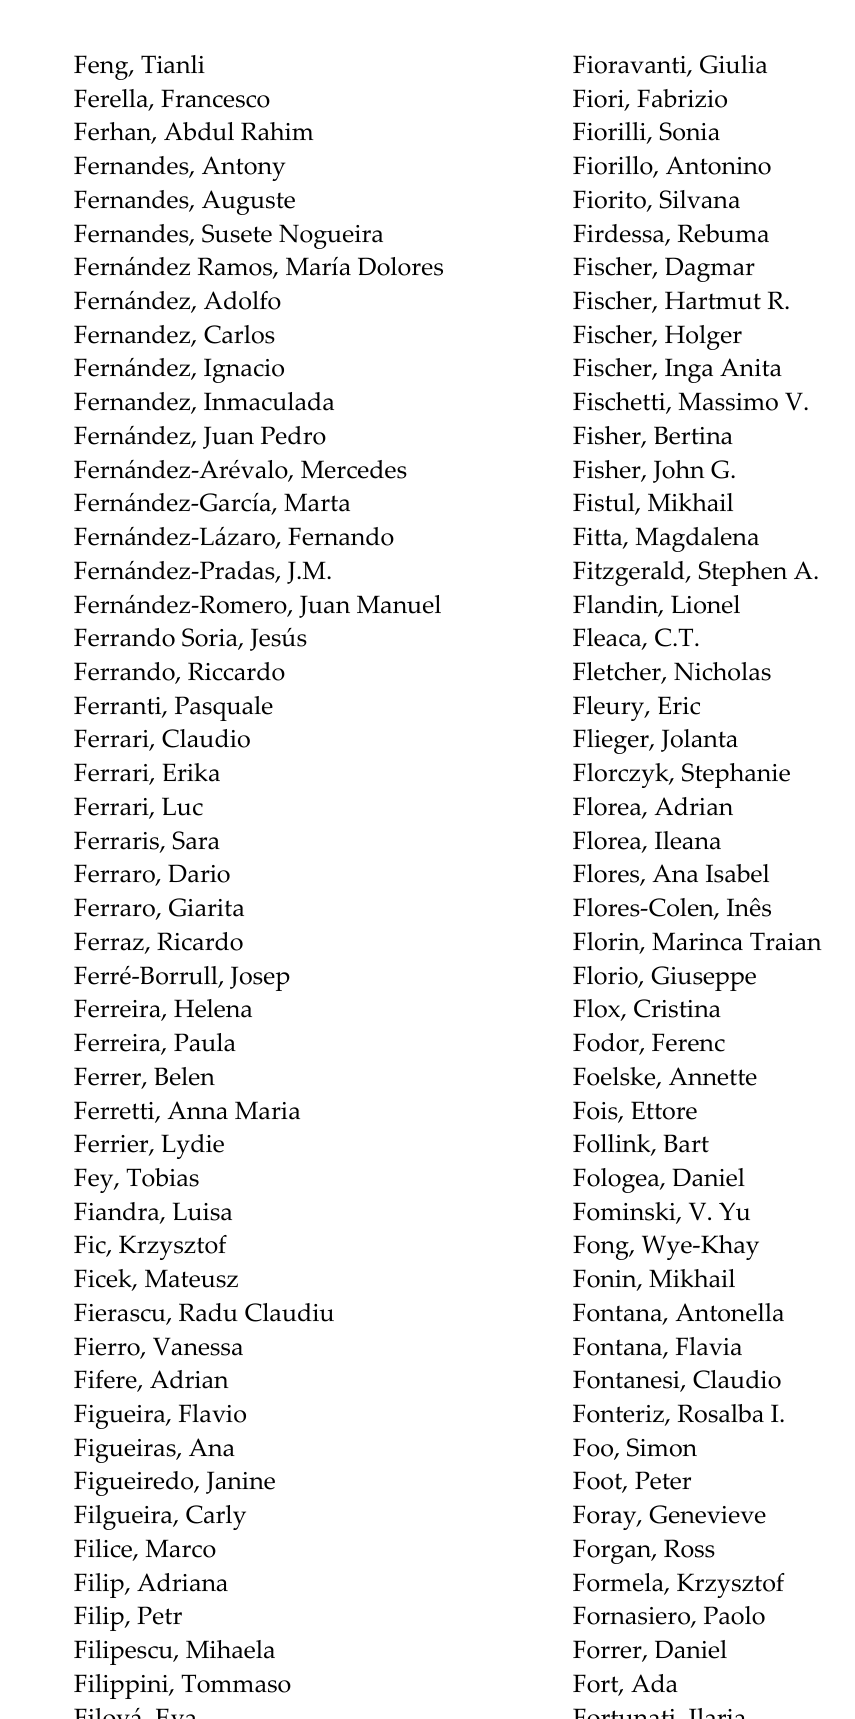
Figueiras, Ana Foo, Simon Figueiredo,